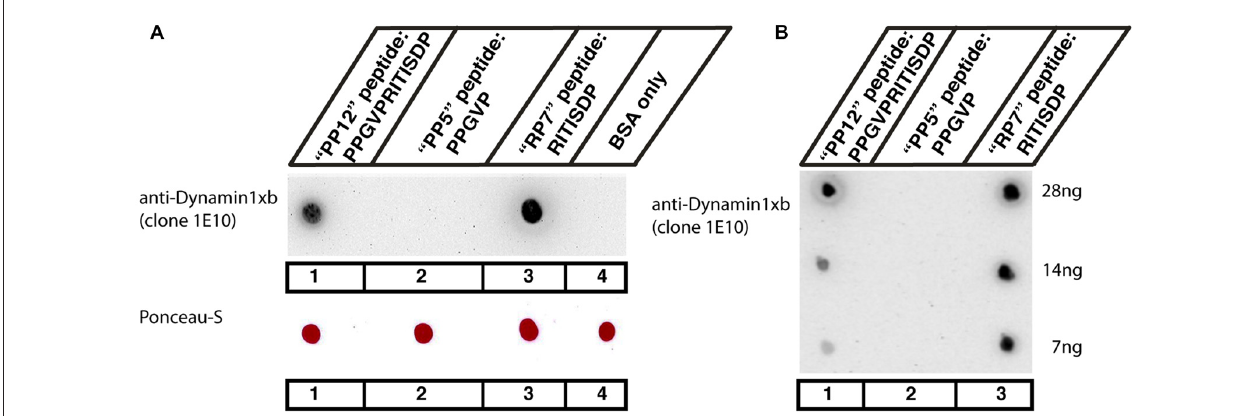
FIGURE 1 | (A,B) Dot blot analyses of the indicated peptides for their reactivity with the dynamin1xb antibody. Three different dynamin1xb peptides with the indicated amino acid (aa) sequence (“PP12”: PPGVPRITISDP, “PP5”: PPGVP, “RP7”: RITISDP) cross-linked to bovine serum albumin (BSA) were spotted on nitrocellulose membrane. BSA only, i.e., BSA with no peptides cross-linked to it, served as a further control in (A) . As expected, the dynamin1xb antibody strongly reacted with the 12mer dynamin1xb peptide (“PP12”) that was used for immunization (spot #1). The antibody also strongly reacted with the dynamin1xb specific carboxyterminal peptide “RP7” that is specific for dynamin1xb (spot #3) but not with the 5mer peptide “PP5” that is common to both dynamin1xa and dynamin1xb (spot #2). The dynamin1xb antibody also did not react with BSA alone (spot #4). Fifty microgram of cross-linked peptide were spotted in (A) . Despite the high amount of the peptides spotted in (A) , the dynamin 1xb selectively reacts with RP7 (spot #3), the dynamin1xb-specific peptide region but not with “PP5” (spot #2). (B) Similar dot blot analyses as also shown in (A) but with less conjugated peptide spotted to the nitrocellulose membrane. The antibody against dynamin1xb selectively detects the “RP7” peptide of dynamin1xb down to an amount of 7 ng. The sensitivity towards the “RP7” peptide appears to be even higher than the sensitivity towards the “PP12” peptide as judged by the immunostaining intensity of the respective peptide spots with the dynamin1xb